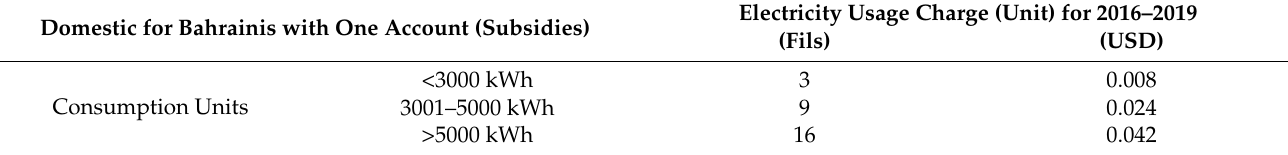
Table 4. Tariff Rates for Bahrainis with one account (Source: